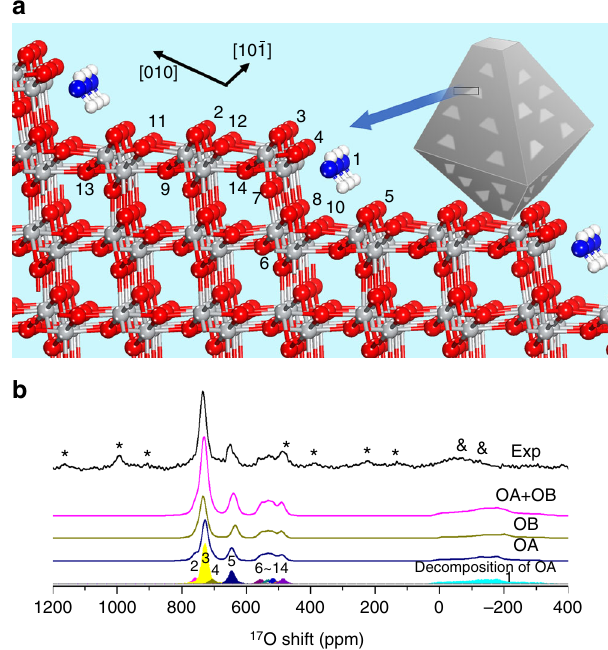
Fig. 3 The structure model and 17 O NMR spectra of NO101-TiO 2 . a The structure model of the TiO 2 (134) vicinal surface for DFT calculations, which contains type-D steps and (101) planes. b The experimental 17 O spin-echo NMR spectrum of the fully dried surface-selectively 17 O-labeled NO101- TiO 2 ( black line ) and the simulated spectra ( colored lines and peaks ) by using parameters obtained from DFT calculations. Water molecules are adsorbed in two orientations (OA and OB). The contributions of both adsorption orientations are also shown in b ( dark yellow line for OB and blue line for OA). Other colored peaks denote the individual components of OA, which correspond to the oxygen atoms labeled with the same numbers in the structural model in a . The parameters adopted in the simulation are listed in Supplementary Table 16. Full views of the models with the two adsorption orientations are presented in Supplementary Figs. 25 – 26. Asterisks denote spinning sidebands, while ampersands denote sidebands that overlap with the signal of the adsorbed